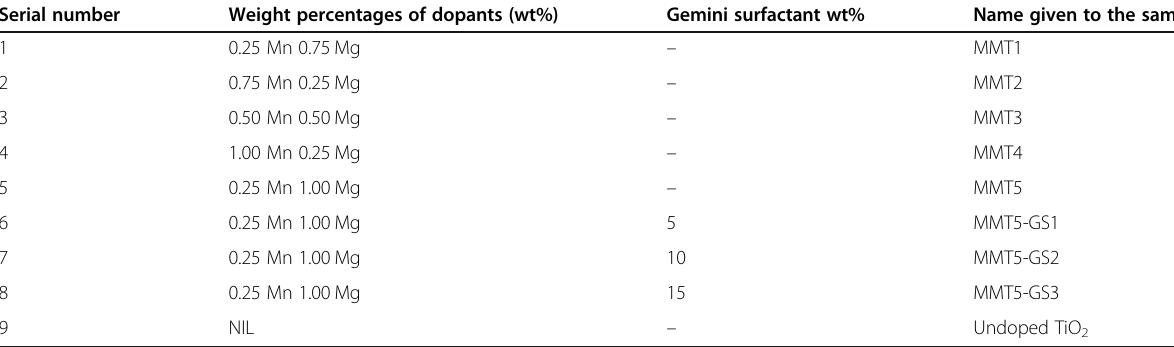
Table 1 Name assigned to different TiO 2 nanocatalyst